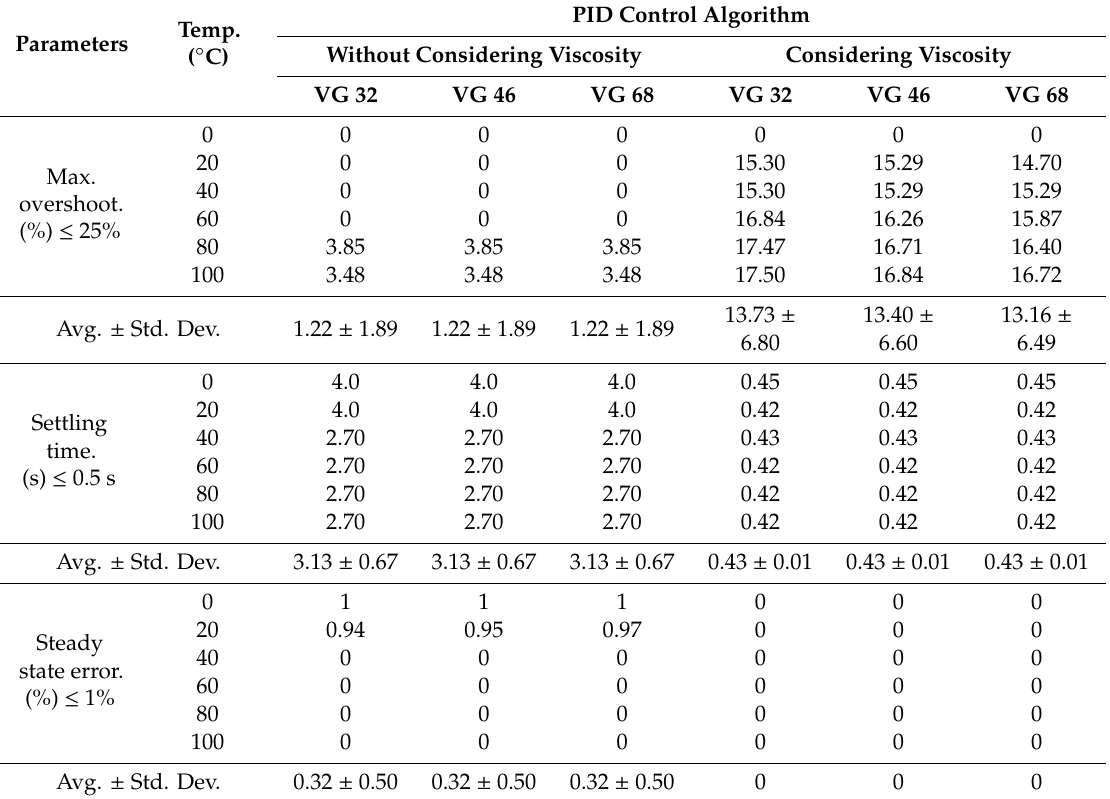
Table 4. Comparison of the response characteristics of the PID control algorithms.